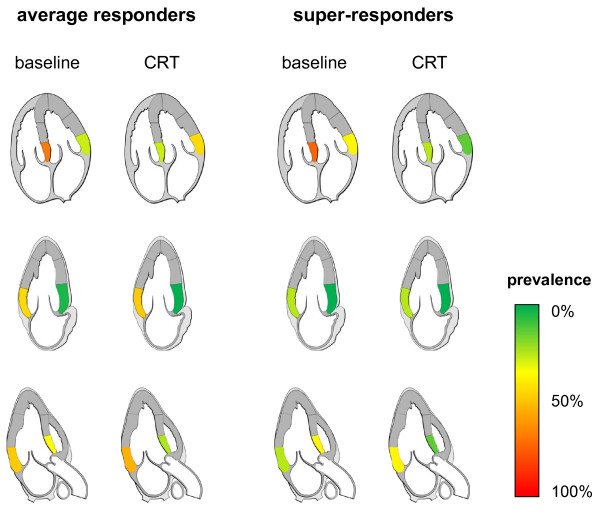
Prevalence of intraventricular asynchrony in six basal segments in average and super-responders before and one day after device implantation (CRT). Upper panel: septal and lateral segments in the four chamber view. Middle panel: anterior and inferior segments in the two chamber view. Lower Panel: anteroseptal and posterior segments in the three chamber view. Illustrations were originally created by Patrick J. Lynch and C. Carl Jaffe, MD and modified with permission under the Creative Commons Attribution 2.5 License 2006.